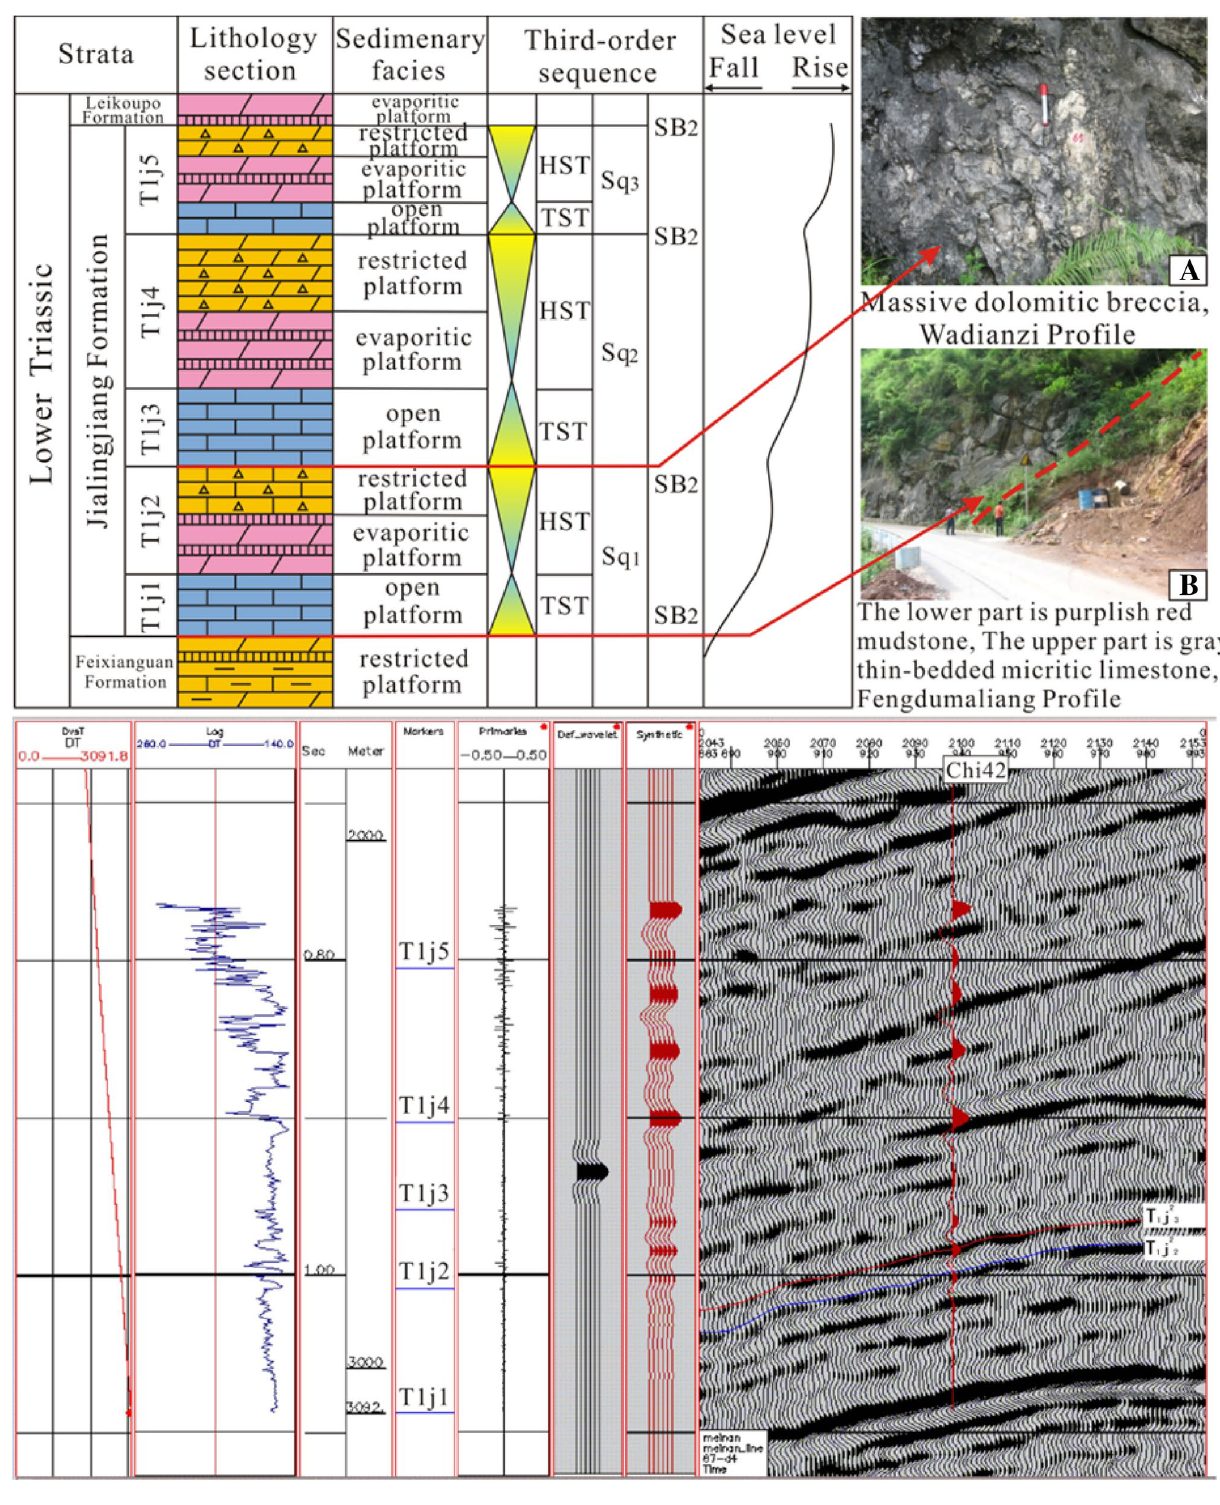
Fig. 3 Sequence stratigraphic divisions in the Jialingjiang